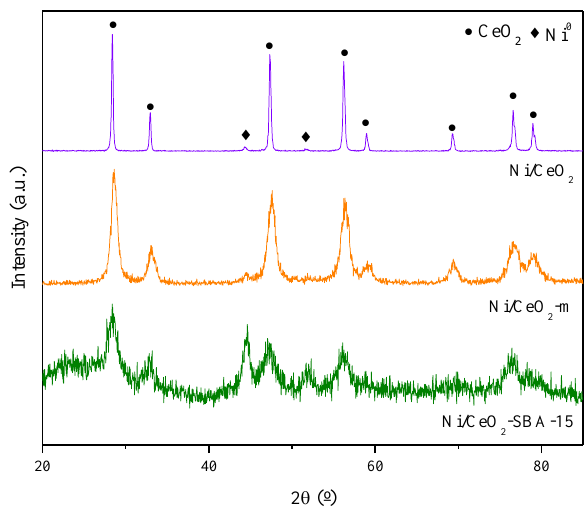
Figure 5. XRD patterns of reduced Ni-based catalysts.